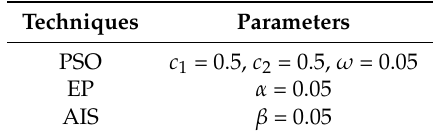
Table 1. List of parameters used in PSO, EP and